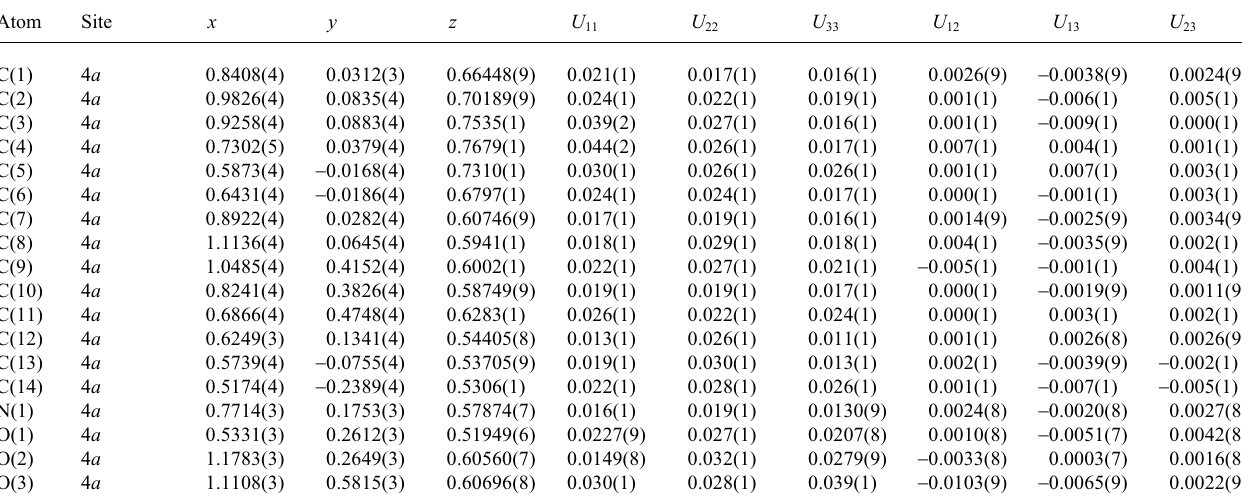
Table 3. Atomic coordinates and displacement parameters (in Å 2